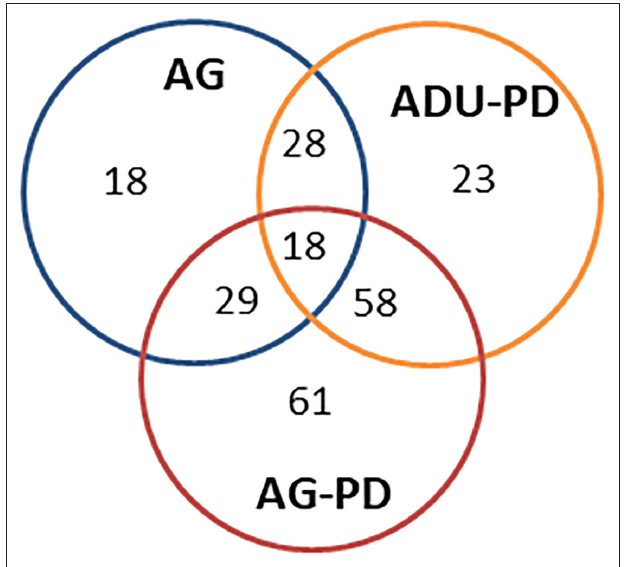
FIGURE 3 | Venn diagram summarizing altered gene expression patterns in aging and naturally occurring periodontitis. The numbers denote unique or overlapping genes in each group that were significantly different and/or altered in expression by > 1.5-fold compared to levels in healthy adult specimens.